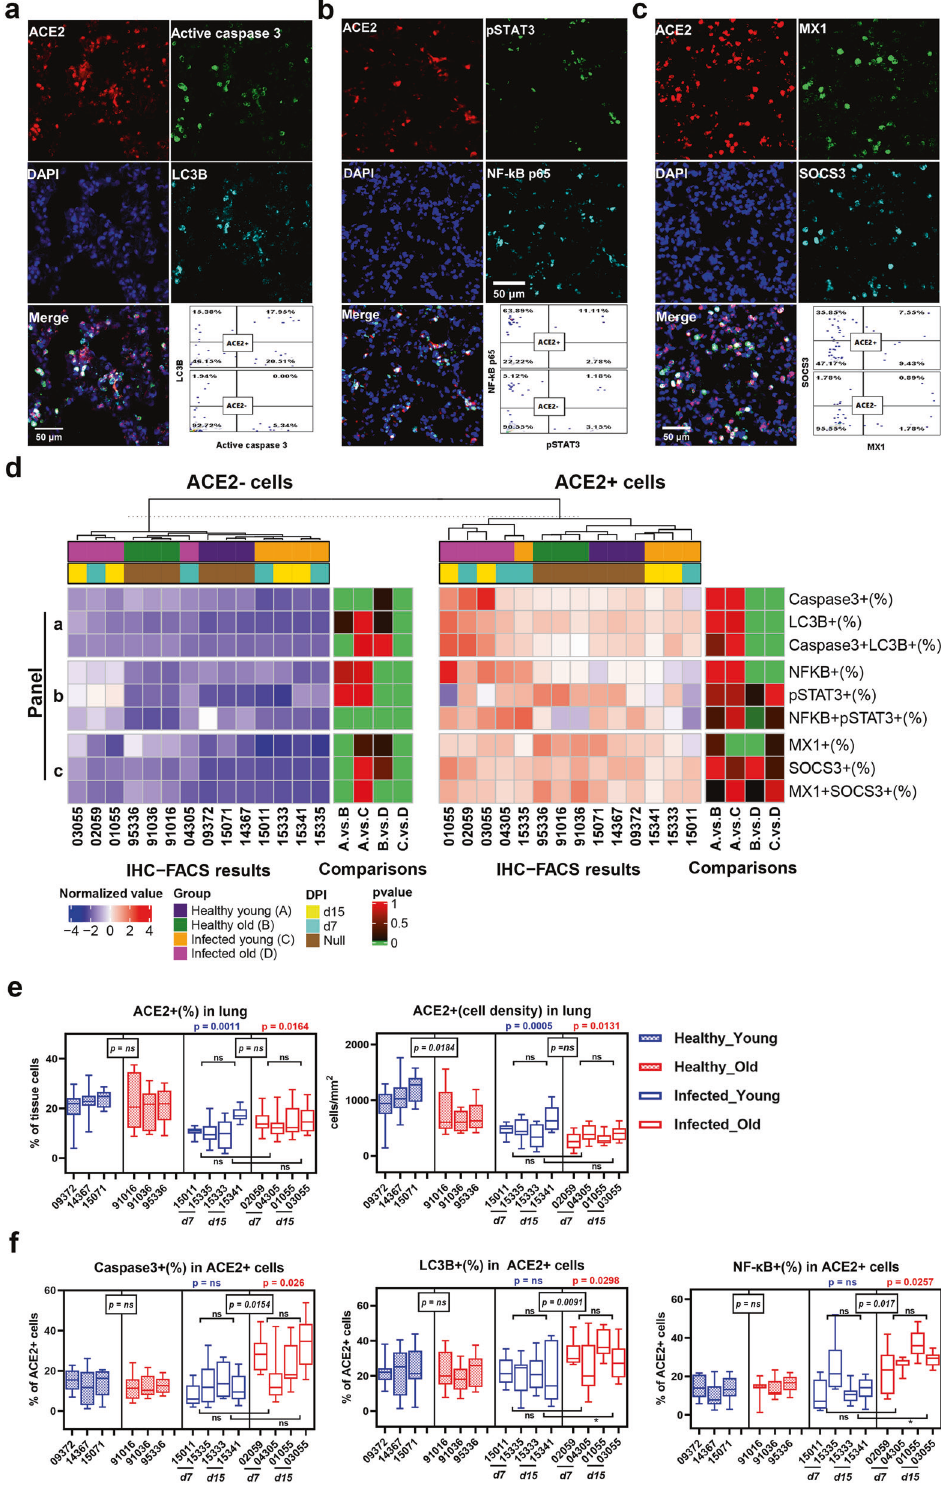
Frequency of CXCR3 + cells increased in spleen tissues and PBMCs of SARS-CoV-2-infected old RMs SARS-CoV-2 infection can cause systemic multiple organ failure and in fl ammation in severe cases 3,4 . However, whether systemic in fl ammation exists in animal models is not yet known. To solve Signal Transduction and Targeted Therapy (2021)